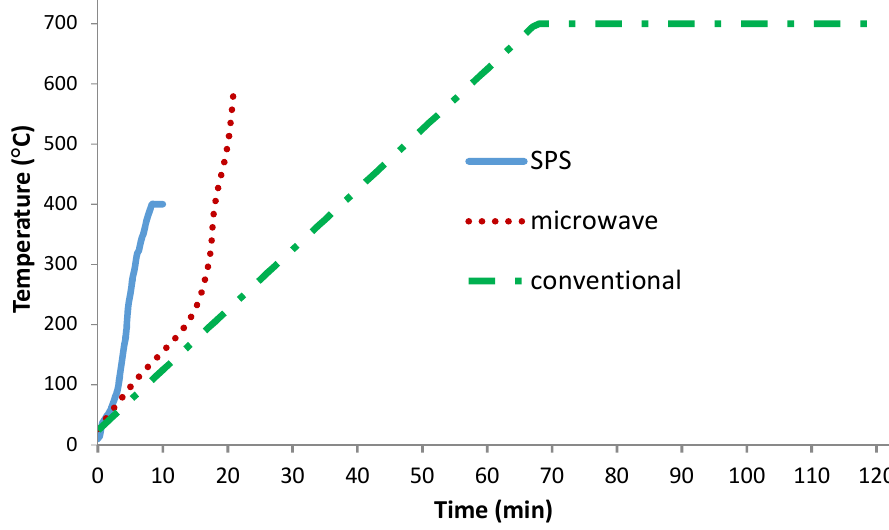
Figure 2. Temperature-time curve for conventional, microwave, and spark plasma sintering processes.